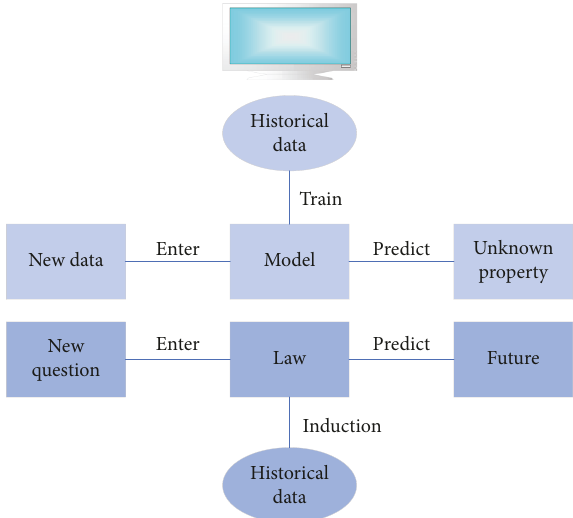
Figure 1: Machine learning